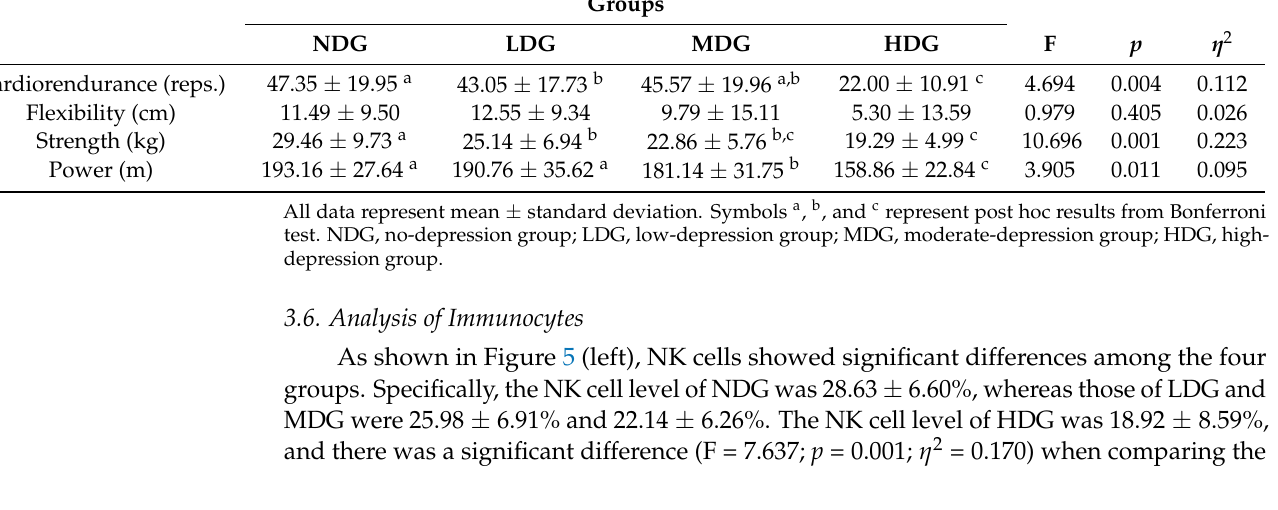
Table 3. Comparative results of physical fitness among the four groups.